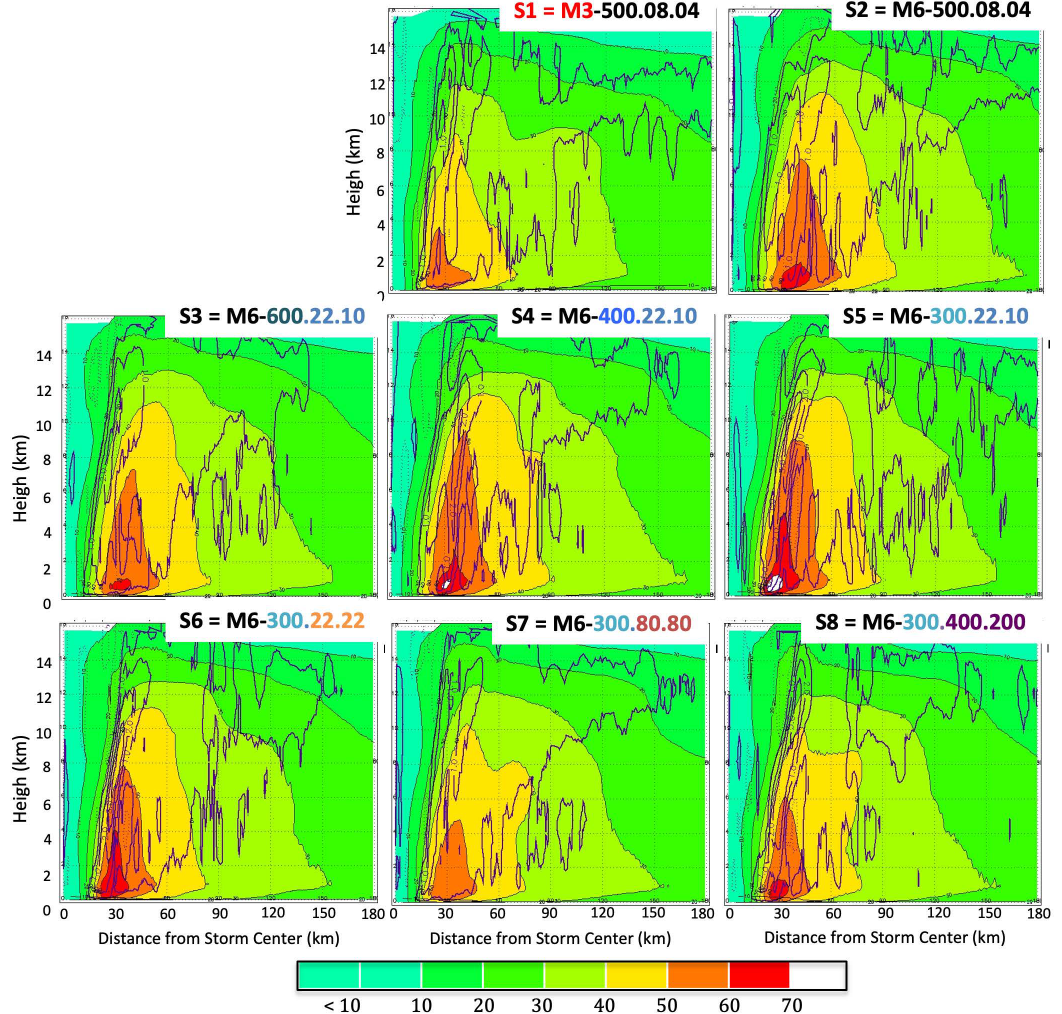
Figure 6. As in Figure 3, except for shown is the azimuthally-averaged tangential flow (in color) and vertical velocity (in